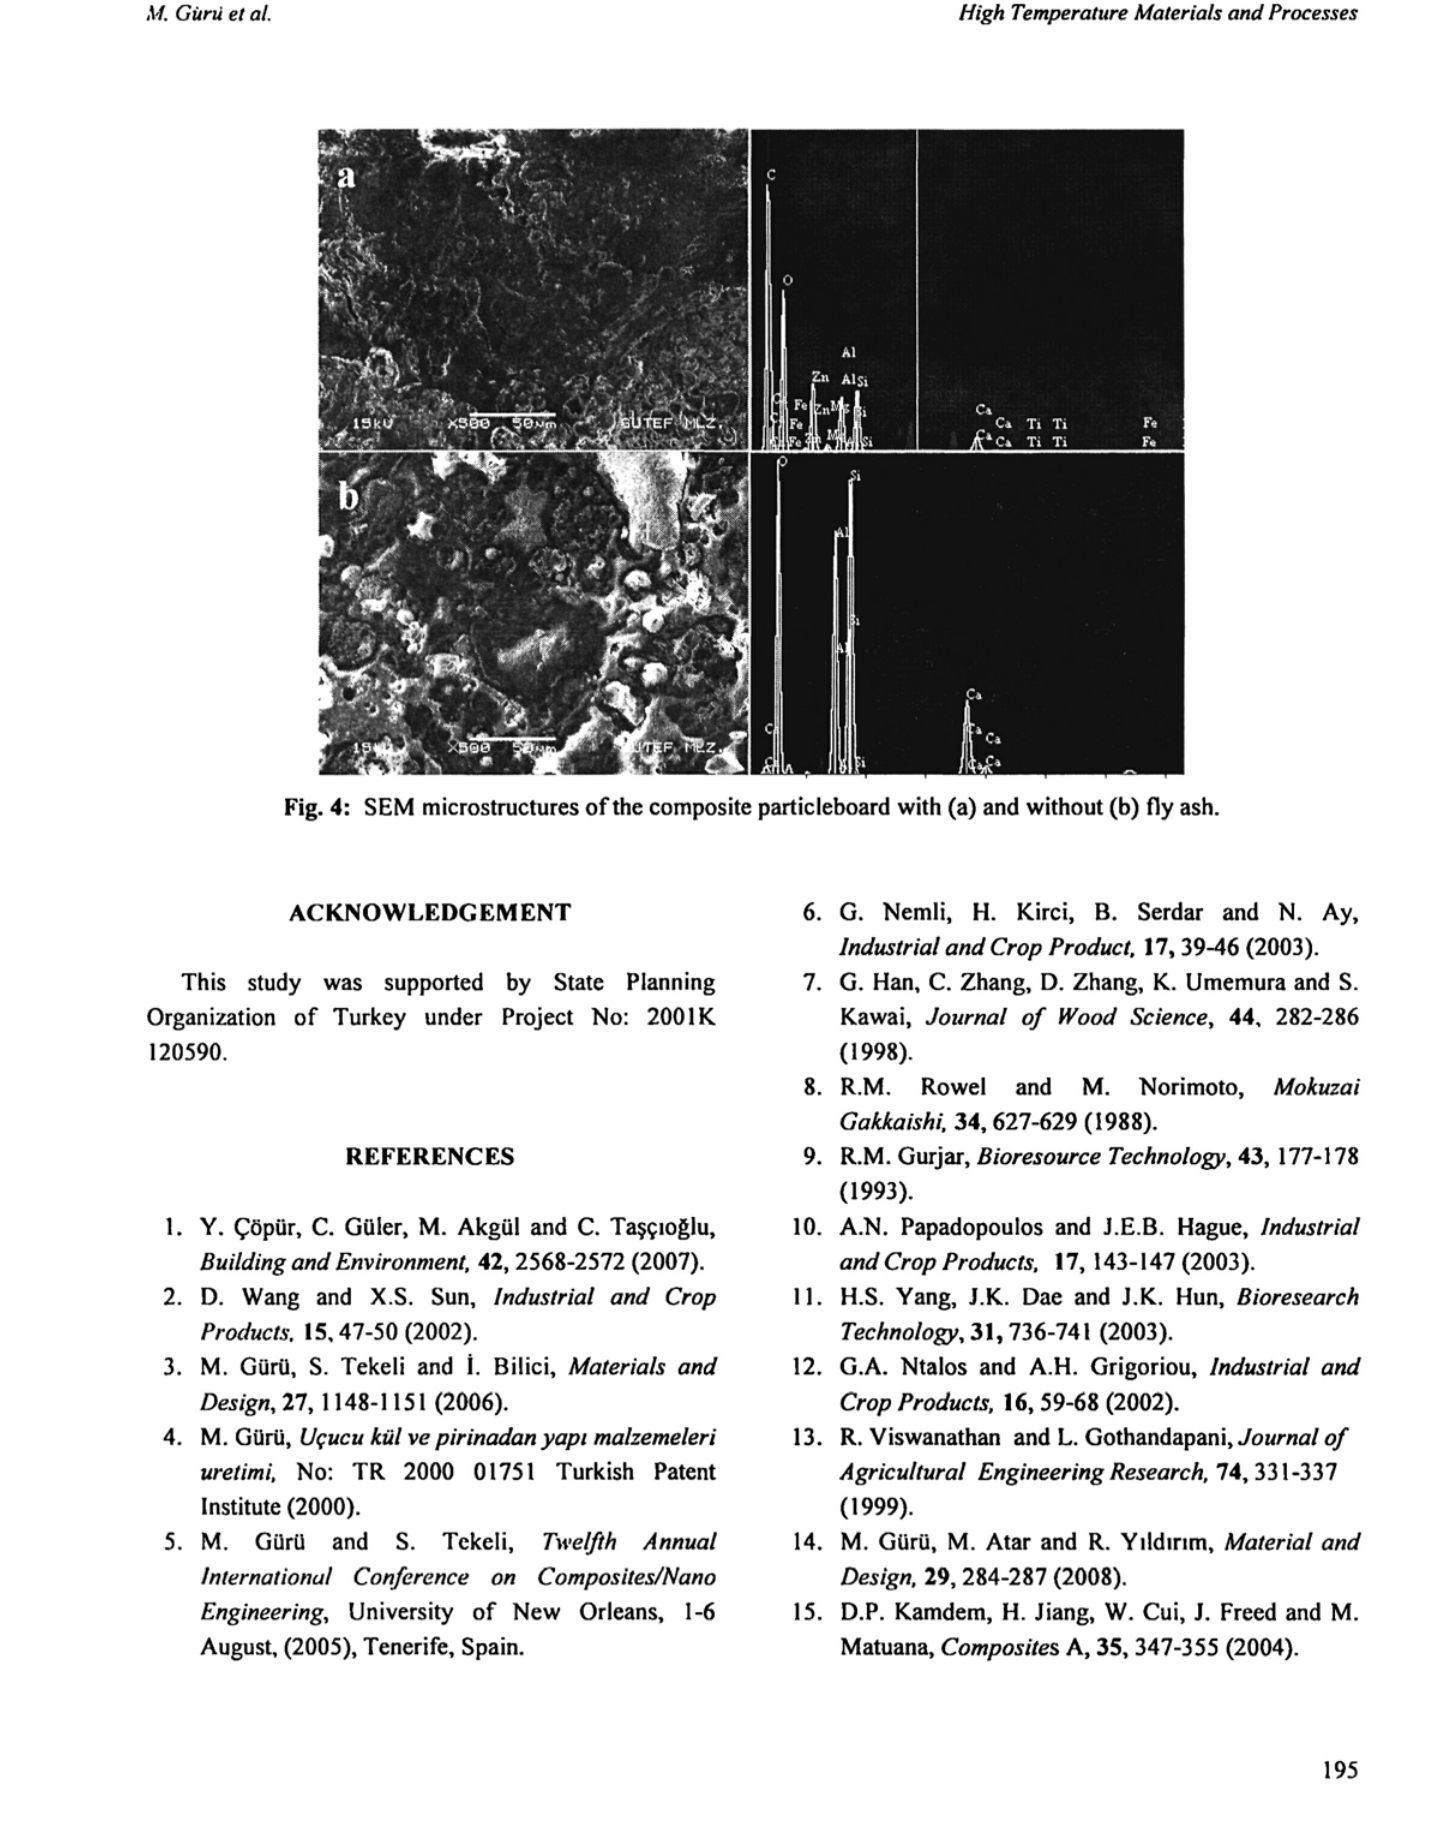
Fig. 4: SEM microstructures of the composite particleboard with (a) and without (b) fly